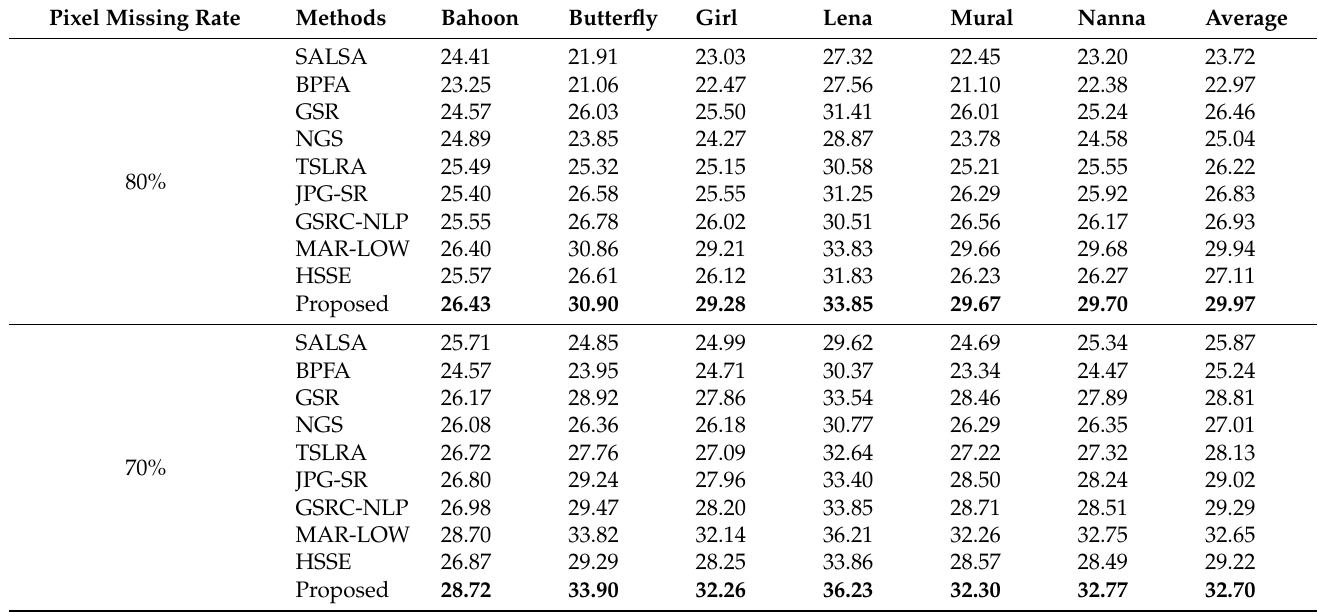
Table 1. PSNR values of the proposed method and some state-of-the-art methods with pixel missing rates 80% and 70%.